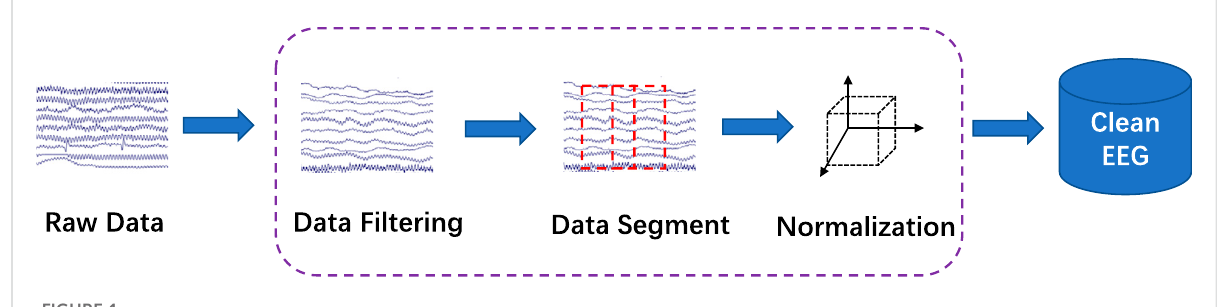
FIGURE 1 EEG preprocessing. The raw EEG was band-pass fi ltered at [0.5 Hz , 128 Hz ]. A 5-s sliding window with a 2-s overlap was used to crop the long- term EEG into segments.